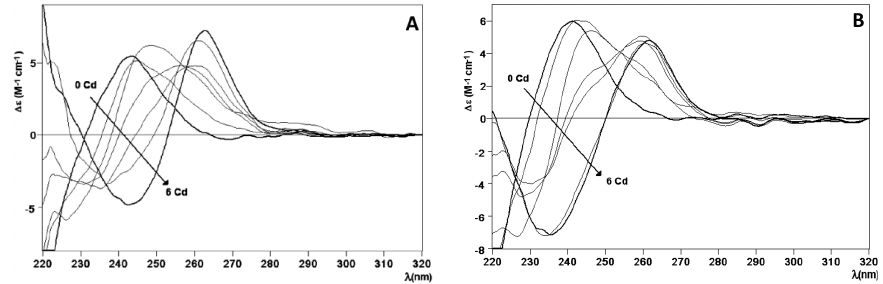
Figure 4. Zn(II)/Cd(II) replacement reaction of the Zn-HpCdMcMT and Zn-HpCdPlMT complexes. ( A ) CD spectra of a 10 µM solution of the Zn-HpCdMcMT sample titrated with CdCl 2 at neutral pH ( A ) CD spectra of a 10 µ M solution of the Zn-HpCdMcMT sample titrated with CdCl 2 at neutral